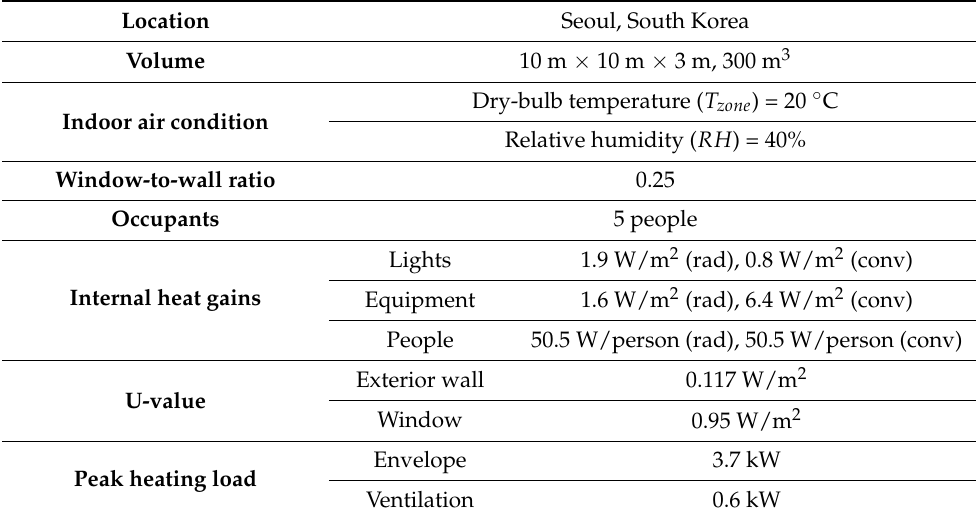
Table 1. Physical parameters of the model space. rad: radiant heating, conv: convective